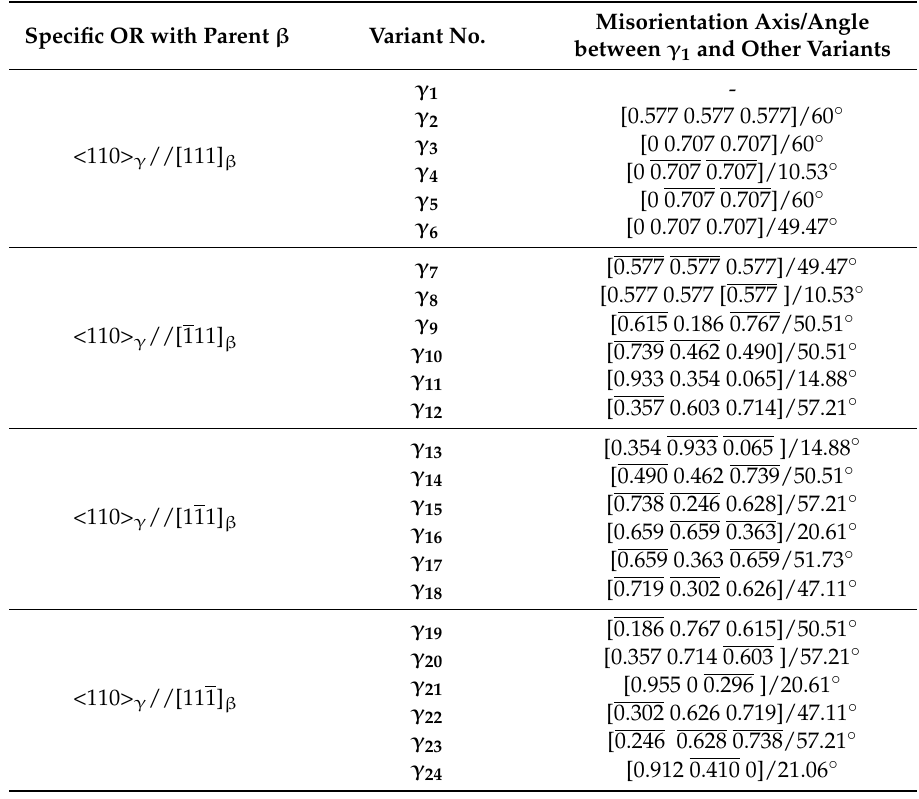
Table 2. The twenty-four γ variants derived from one β grain and the crystallographic relationships between γ 1 and other variants. The variant numbers correspond to those in Figure